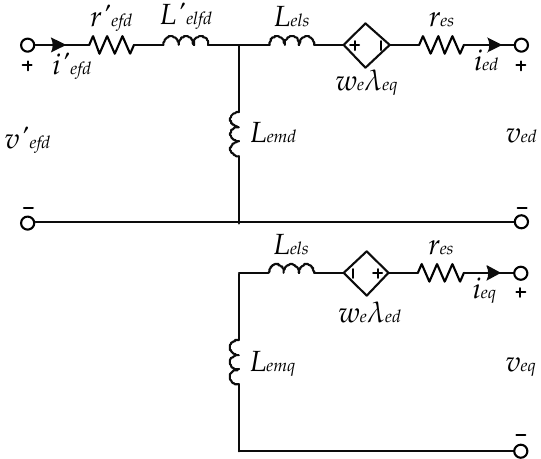
Figure 4. Equivalent circuit of the exciter. The output of the exciter was connected to a rotating rectifier, a three-phase uncon- trolled full-bridge rectifier circuit that was a nonlinear link and, therefore, needed to be linearized. In [23], a synchronous generator model with a rectified load was linearized by averaging the variables in the d – q reference frame. The average model is shown in Figure 5.